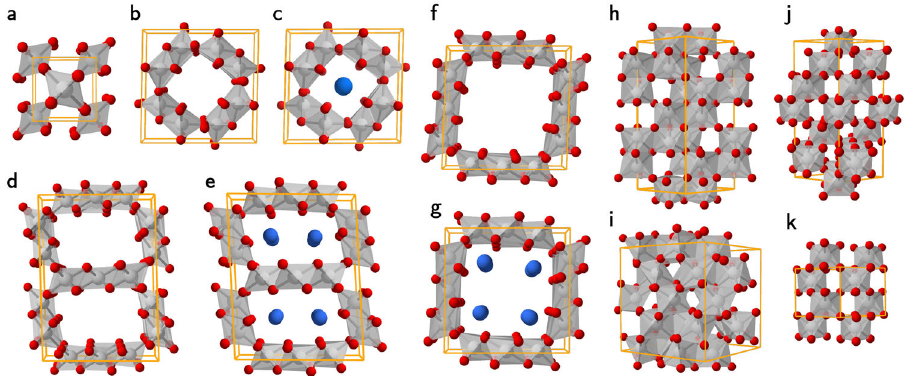
Fig. 1 Atomic and crystal structures of the crystalline iridium oxides. a Rutile-type R-IrO 2 . b Hollandite-type Ho-IrO 2 . c K-intercalated hollandite-type 1K + Ho-IrO 2 . d Romanechite-type Ro-IrO 2 . e K-intercalated romanechite-type 2K + Ro-IrO 2 . f Todorokite-type To-IrO 2 . g K-intercalated todorokite-type 4K + To-IrO 2 . h Corundum-based C-IrO 1.5 . i bixbyite-based B-IrO 1.5 . j R 3 c R-IrO 3 . k P 6 3 22 P-IrO 3 . The iridium, oxygen, and potassium atoms are depicted as gray, red, and blue spheres, respectively, while the octahedra of IrO 6 is shaded in gray. The bulk unit cell is represented by the lines Table 1 Calculated lattice parameters, space group, and thermodynamic properties. Ir – O system